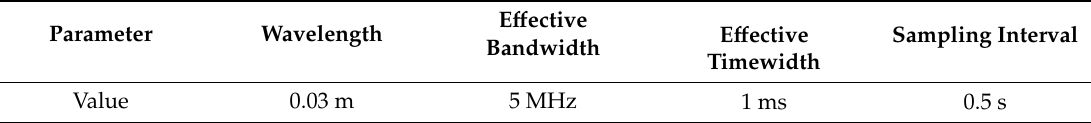
Table 2. Parameters of radars.